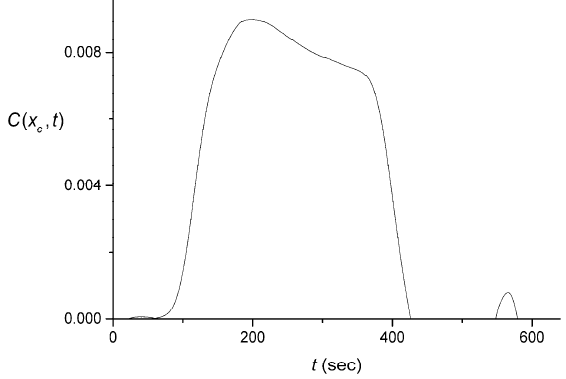
Figure 7. Example of a rectangular input pulse C p x c , t q generated from the averaged output S p t q , which was in turn obtained for one of the signals presented in Figure 1A, the same one that was used for Figure